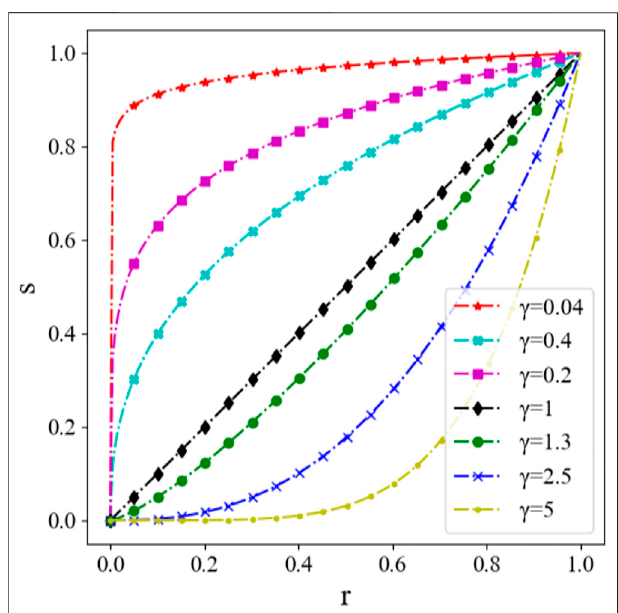
FIGURE 9 | Schematic diagram of Gamma transformation with different factor γ